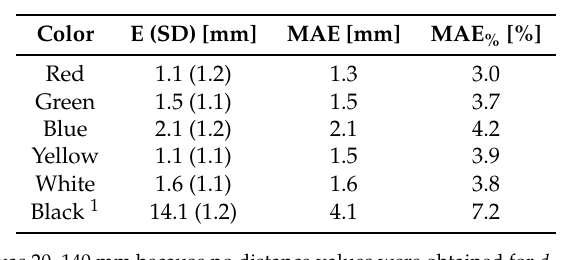
Table 1. Overall mean error with standard deviation (E (SD)), mean absolute error (MAE) and mean absolute percentage error (MAE % ) of the distance for the six target colors.